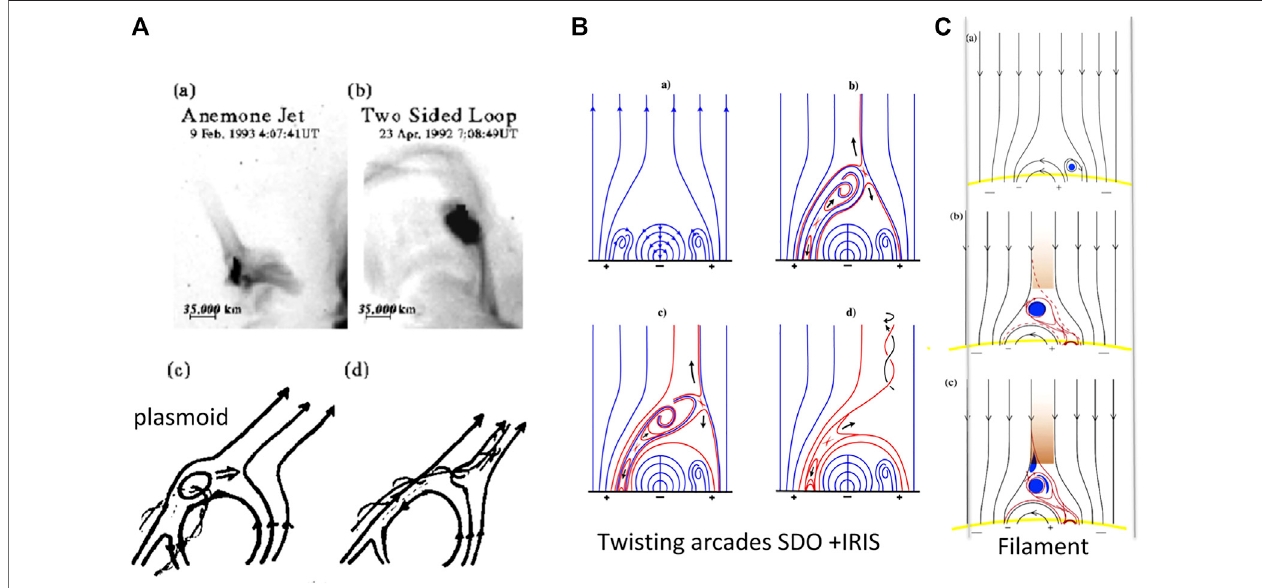
FIGURE 2 | Cartoons representing the initiation of jets. Left column (A) : (panela) two kinds ofX-ray jets observed with Yohkoh: anemone jet and two-side loop jet, panel(b)uni fi edCSHSPmodelof fl aresand fl uxemergingmodel:theplasmoid-inducedreconnectionmodelproposedbyYokoyamaandShibata(1995);Shibata(1998) [adapted from Shibata (1999)]. The plasmoid is a magnetic island or a twisted fl ux rope. Middle column (B) : a possible formation mechanism of penumbral jets from the eruptionofamagneticarcade(thecoreofwhichbecomesatwisted fl uxropeasiterupts)insertingshearandtwistinthejetspine.Inthissketch,onlythe “ cross-cut/ section ” across the central axis of the tail of the penumbral fi lament is represented so that the fi eld in the fi lament head is behind the viewer (in the line of sight) [adapted fromTiwarietal.(2018)].Rightcolumn (C) :blowoutjetinitiatedbyamini fi lament;inpanel(b),tworedcrossesindicate2sitesofreconnection:thelowcrosscorresponds to tether cutting reconnection and a bright point loop forms below; the top cross corresponds to break-out [adapted from Sterling et al. (2015); Sterling and Moore (2020)].